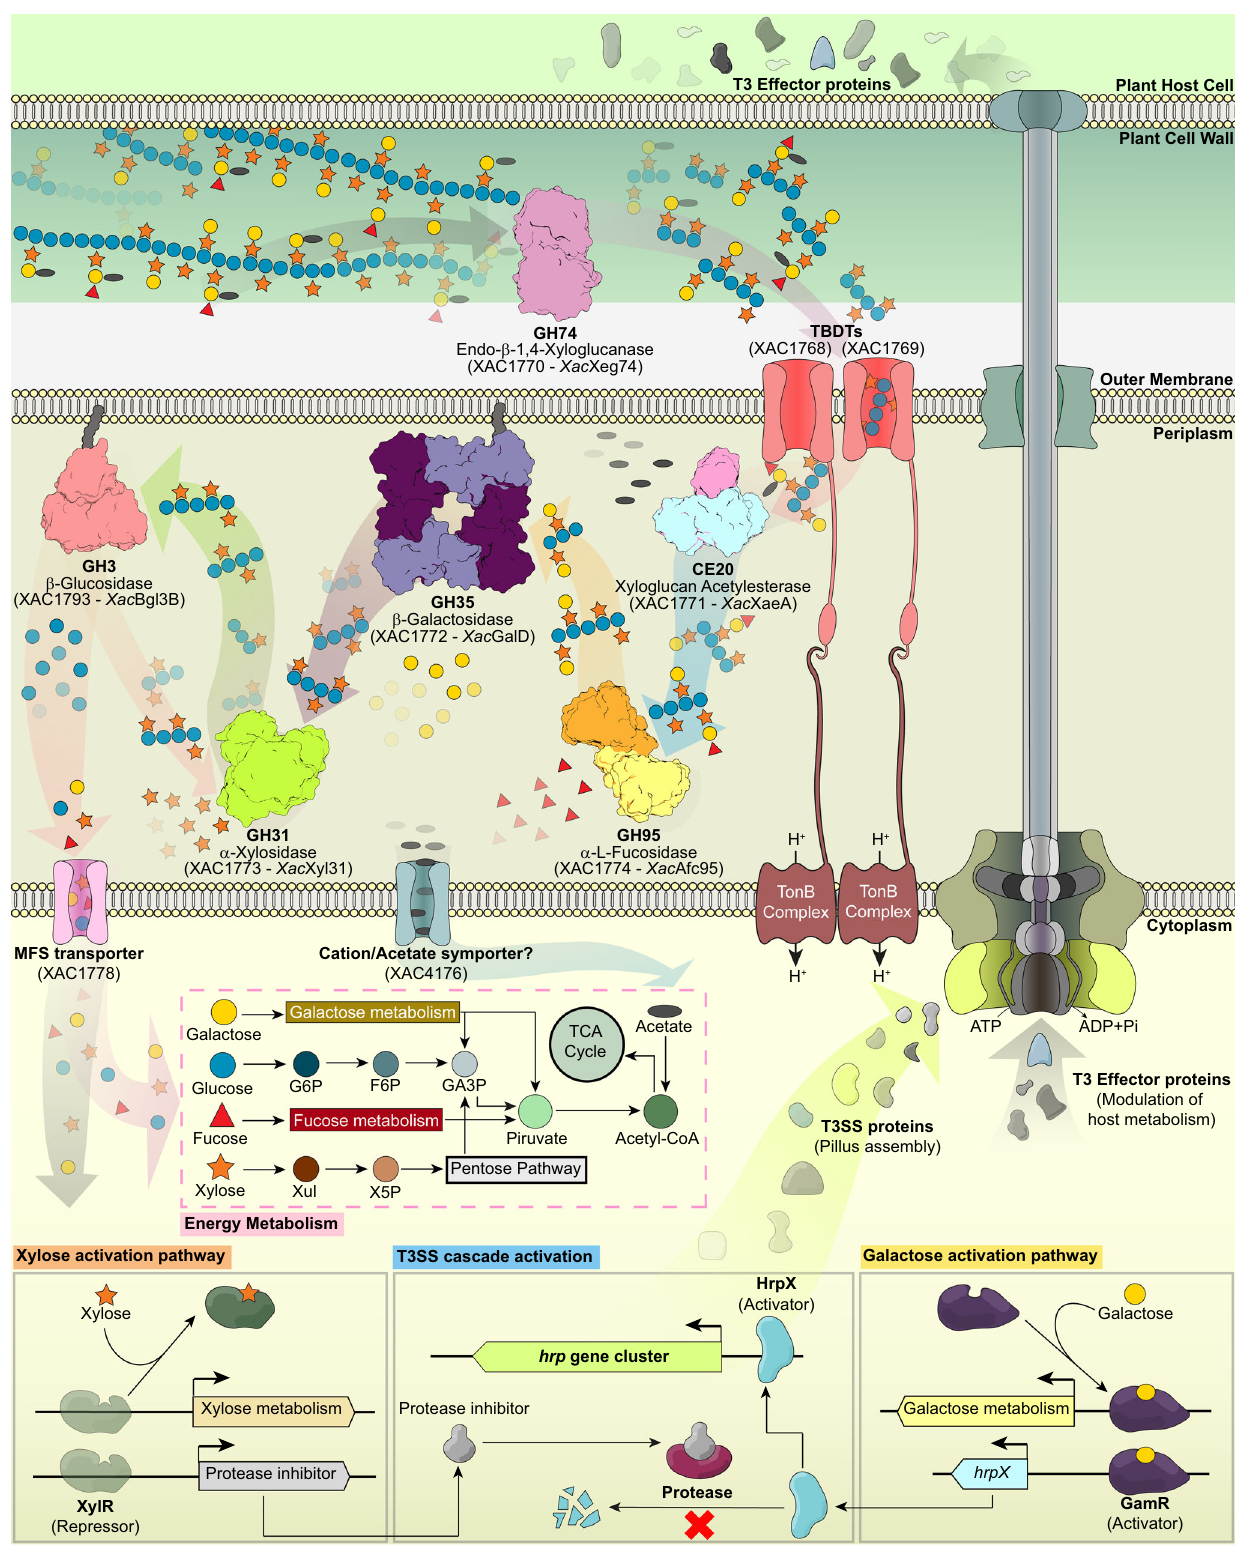
Fig. 6 XyG enzymatic breakdown and the role of released products in the metabolism and virulence of X. citri . Representation of the pathogen-host cell interface highlighting how XyG is progressively depolymerized by Xanthomonas enzymes and internalized by transmembrane transporters. In this bacterium, monosaccharides released from XyG induce the expression of multiple genes, including the T3SS machinery via mechanisms suggested based on transcriptional data and literature 54 – 56 (details in Supplementary Fig. 28, and Supplementary Table 1). T3, Type III; T3SS, Type III secretion system; TBDTs, TonB-dependent transporters; MFS, major facilitator superfamily transporter; G6P, D-glucose-6-phosphate; F6P, D-fructose-6-phosphate, GA3P, D-glyceraldehyde 3-phosphate; Xul, D-xylulose; X5P, D-xylulose 5-phosphate; and TCA, Tricarboxylic Acid